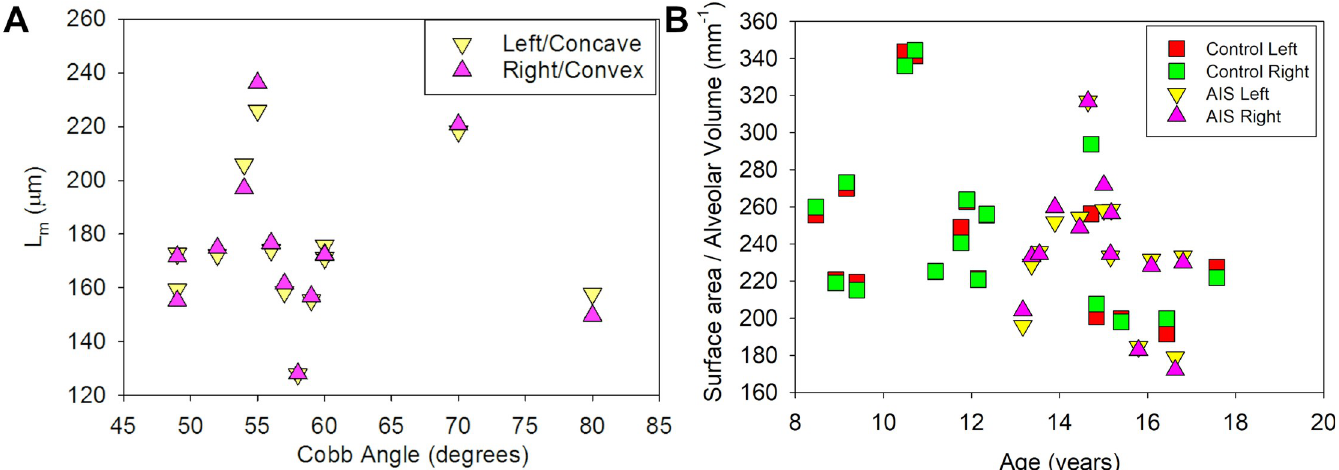
Fig 2. Impact of AIS on distal lung architecture. (A) All AIS subjects had levoscoliosis. The mean linear intercept (L convex lungs. (B) Alveolar surface to volume ratio decreased with age as expected since alveolar size increases and neoalveolarization slows during adolescence. There was no discernible difference between control and AIS groups or between right and left lungs with regard to this derived value.